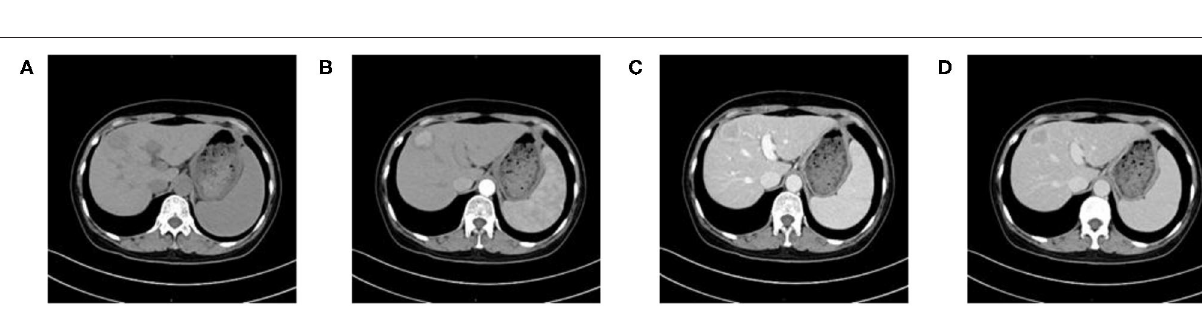
FIGURE 2 | A 59-year-old woman with HCC who is MVI-positive. (A) Non-enhanced phase showing a low-density tumor in the hepatic segment IV, (B) arterial phase showing a hyper-vascular tumor with obvious enhancement, (C) portal venous phase, and (D) equilibrium phase display non-smoothed tumor margin and